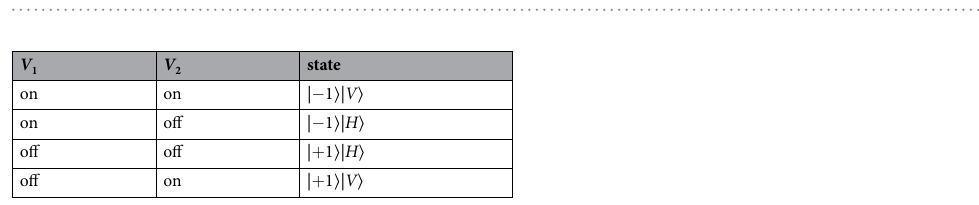
Table 2. Characteristic data of designed PPLN-based polarization mode converter.